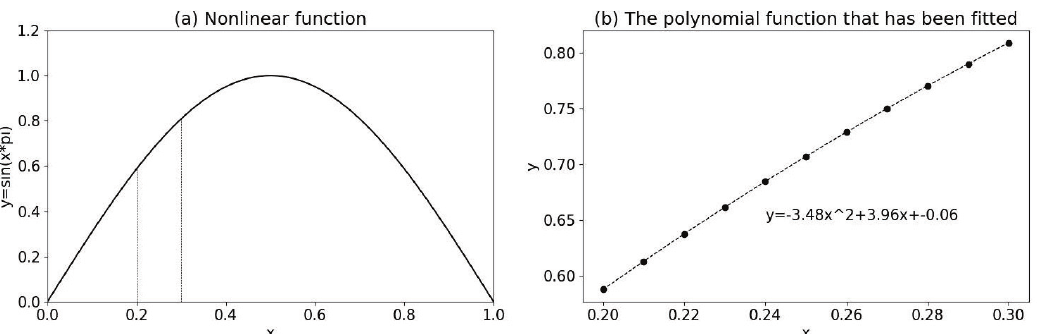
Figure 2. The process of binomial fitting. ( a ) Nonlinear function and the selected segment. ( b ) Fitting curve obtained by binomial fitting according to the scatter